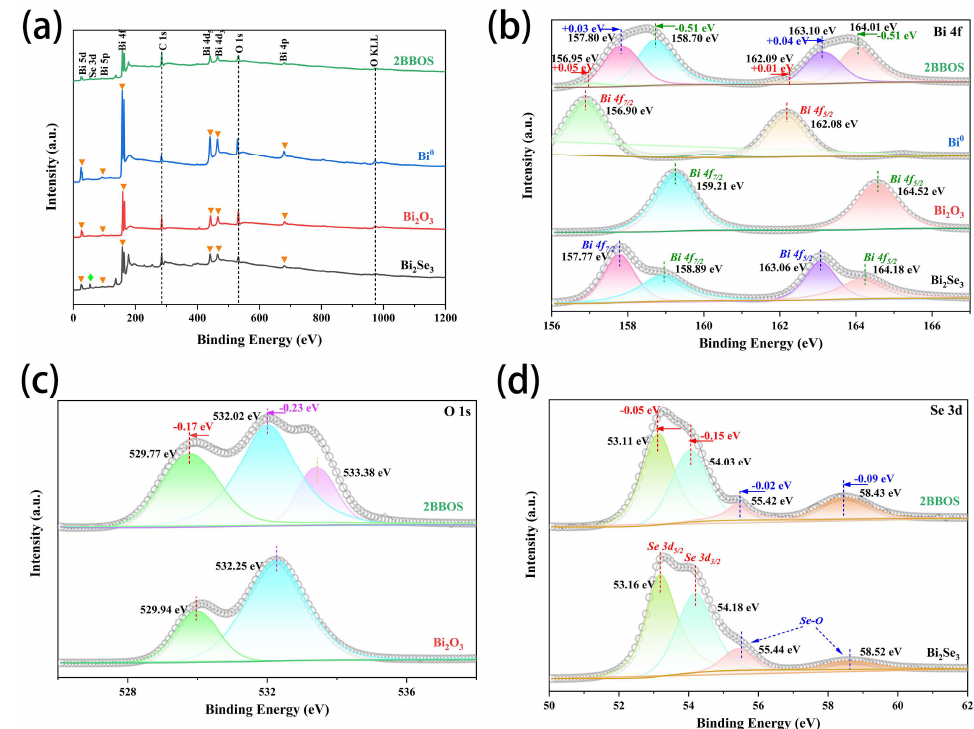
Figure 5. XPS spectra of Bi 2 Se 3 , Bi 2 O 3 , Bi 0 , and 2BBOS samples: ( a ) survey, ( b ) Bi 4f, ( c ) O 1s, and ( d ) Se 3d ( (cid:72) corresponding to Characteristic peaks of the Bi, (cid:7) corresponding to Characteristic peaks of the